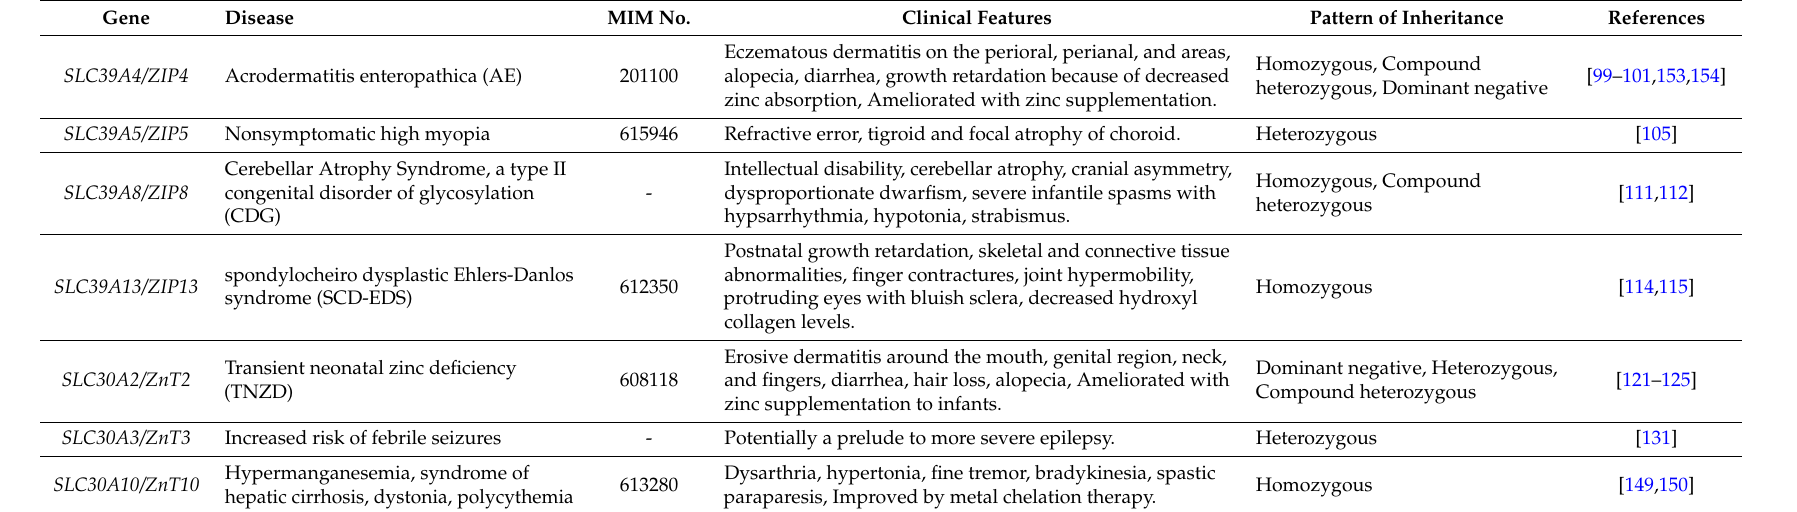
Table 3. Zinc transporter mutations reported to be involved in inherited